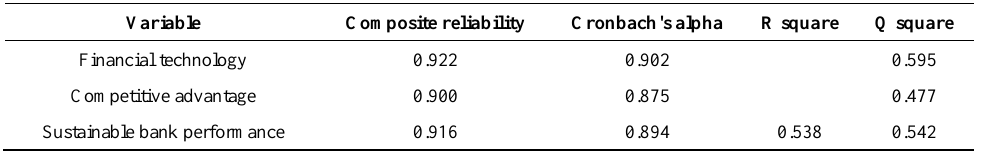
Table 1. Test of inner and outer model